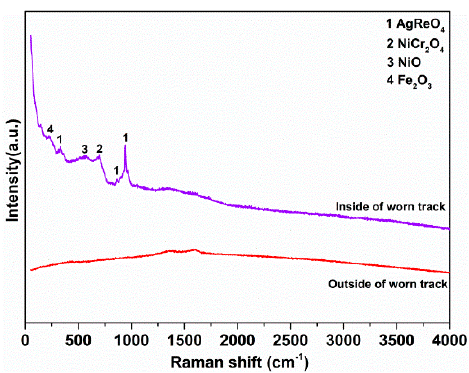
Figure 13. The Raman spectra of the worn surface after sliding friction test lubricated with oil containing 0.5 wt% AgReO 4 additive at 400 °C.